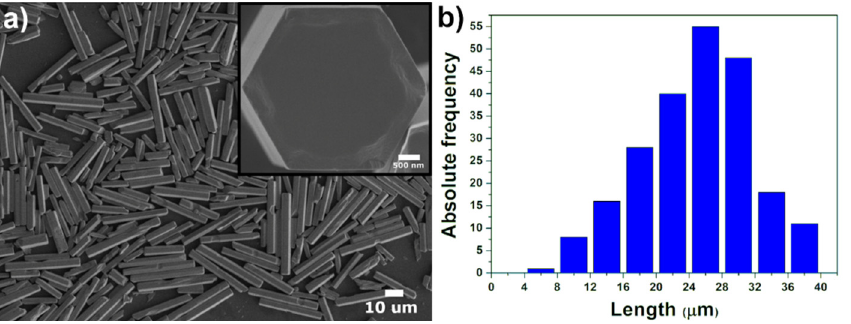
Figure 2. ( a ) SEM image and ( b ) length distribution of the h-MoO 3 microrods. Right inset in ( a ): SEM cross section image of a microrod.